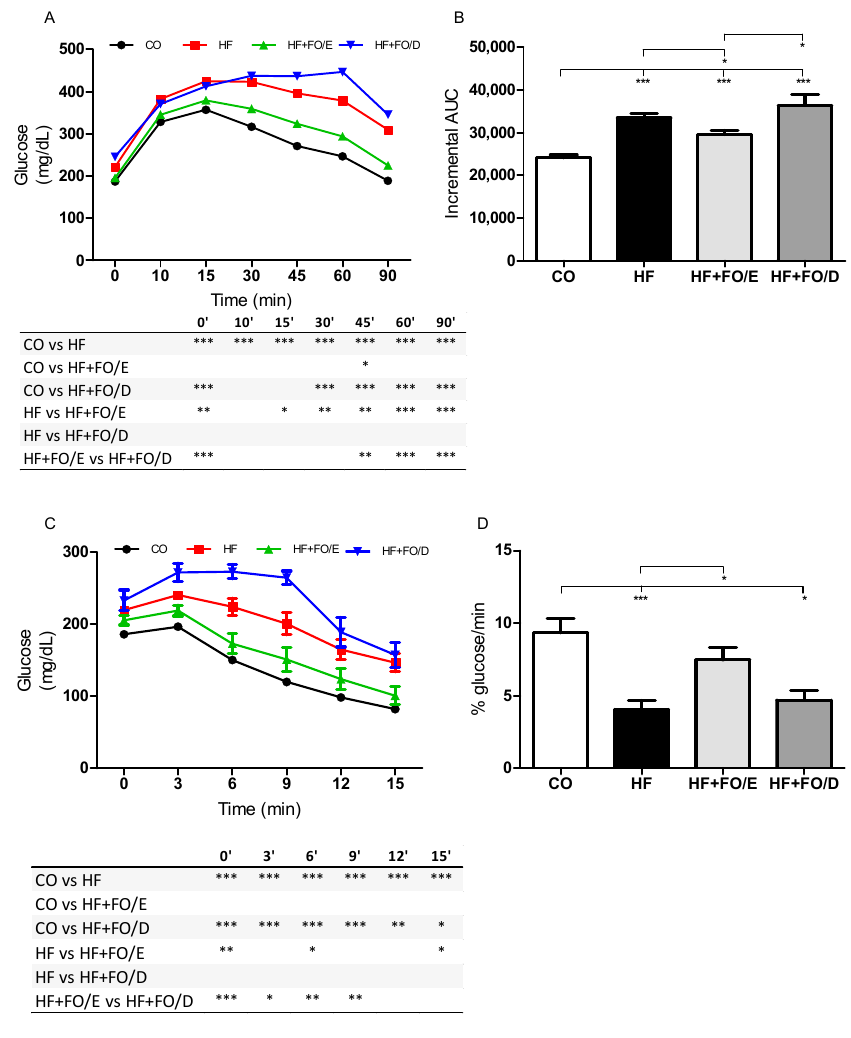
Figure 3. GTT and ITT of mice fed with CO or HF diet and treated with FO. HF+FO/E, HF diet supplemented with FO containing high concentration of EPA. HF+FO/D, HF diet supplemented with FO containing high concentration of DHA. ( A ) GTT, blood glucose concentration versus time after glucose administration. ( B ) Incremental area under the GTT curve. ( C ) ITT, glucose decay curve versus time after insulin administration. ( D ) Glucose disappearance rate for ITT (kITT). FO: fish oil; CO: control diet; HF: high fat diet; HF+FO/E, HF diet supplemented with FO containing high concentration of EPA; HF+FO/D, HF diet supplemented with FO containing high concentration of DHA; GTT: glucose tolerance test; ITT insulin tolerance test. Mean ± SEM. * p < 0.05, ** p < 0.01, *** p < 0.001.